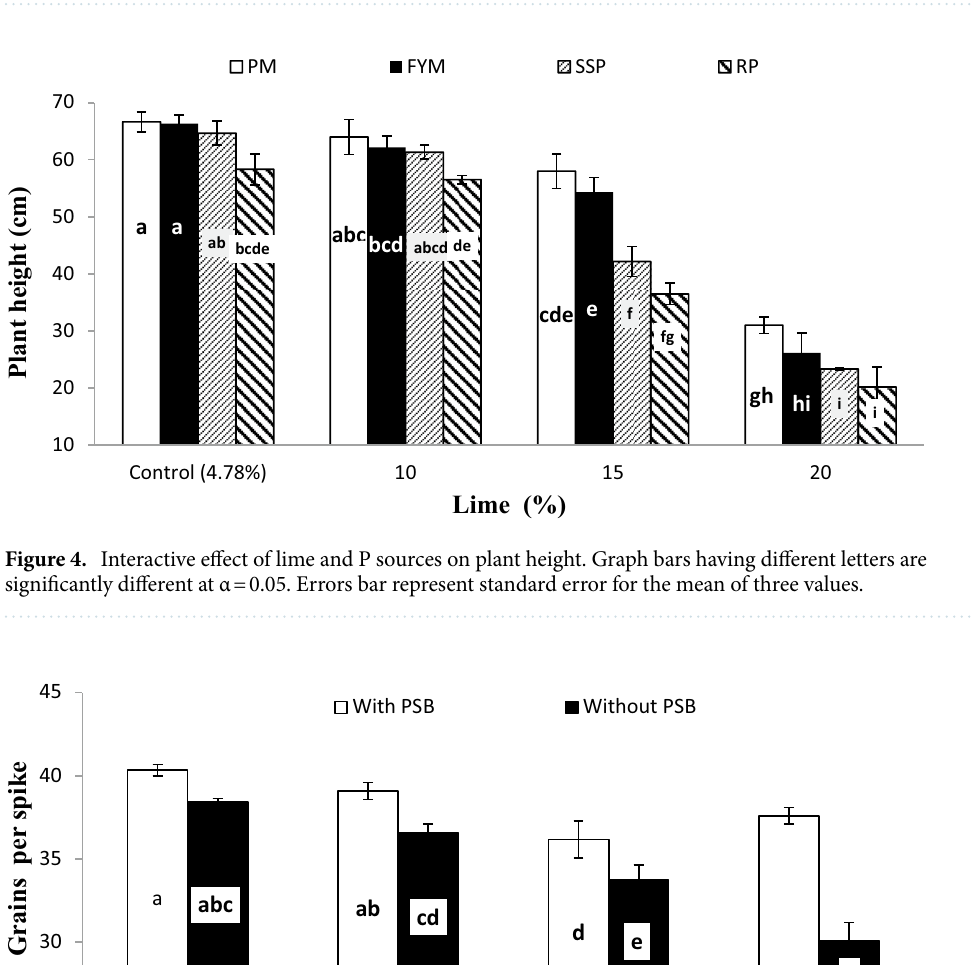
Figure 3. Interactive effect of lime and PSB on wheat tillers per plant. Graph bars having different letters are significantly different at α = 0.05. Errors bar represent standard error for the mean of three values.